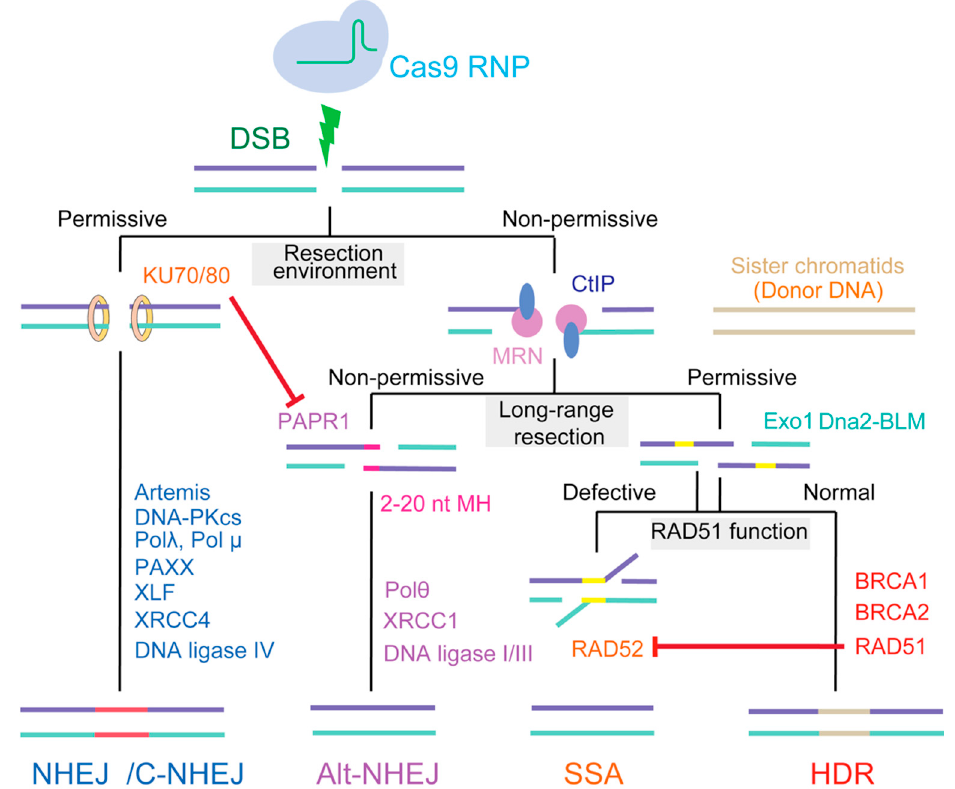
Figure 1. The hierarchy of repair pathways choice in mammalian cell. NHEJ (nonhomologous end joining) is the first choice DSB (double strands break) repair pathway in mammalian cells, occurring in all cell cycle phase. Preliminary end resection is necessary for the DSB repair according to HDR (homology-directed repair), SSA (single-strand annealing), and alt-NHEJ (alternative NHEJ) mechanisms. Resection during alt-NHEJ is relatively short, and extended resection favors HDR. SSA can function opportunistically on ssDNA (single strand DNA) ends or on recombination intermediates, especially RAD51, by hijacking the HDR process.